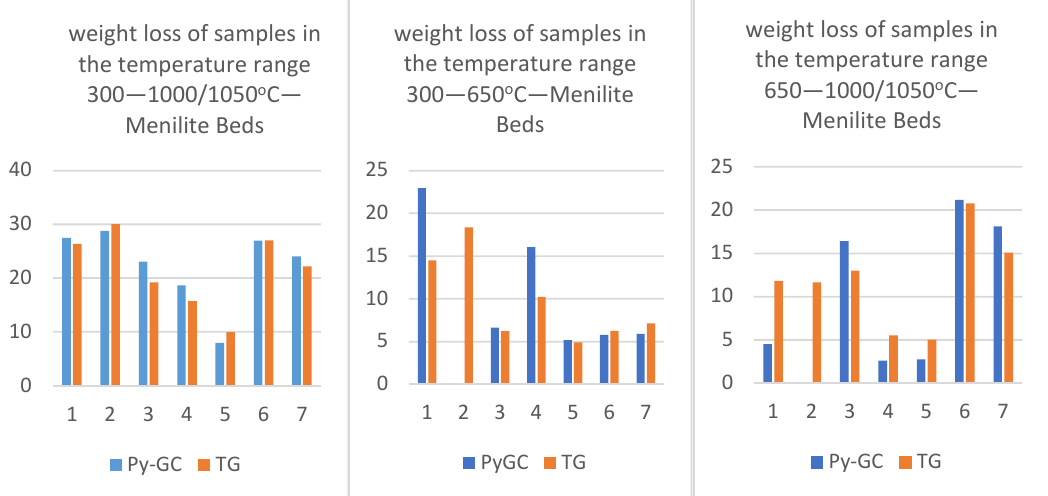
Figure 7. Comparison of weight loss (%) during Py/GC and TG/DSC pyrolysis of Menilite Bed samples in total and in two temperature ranges.